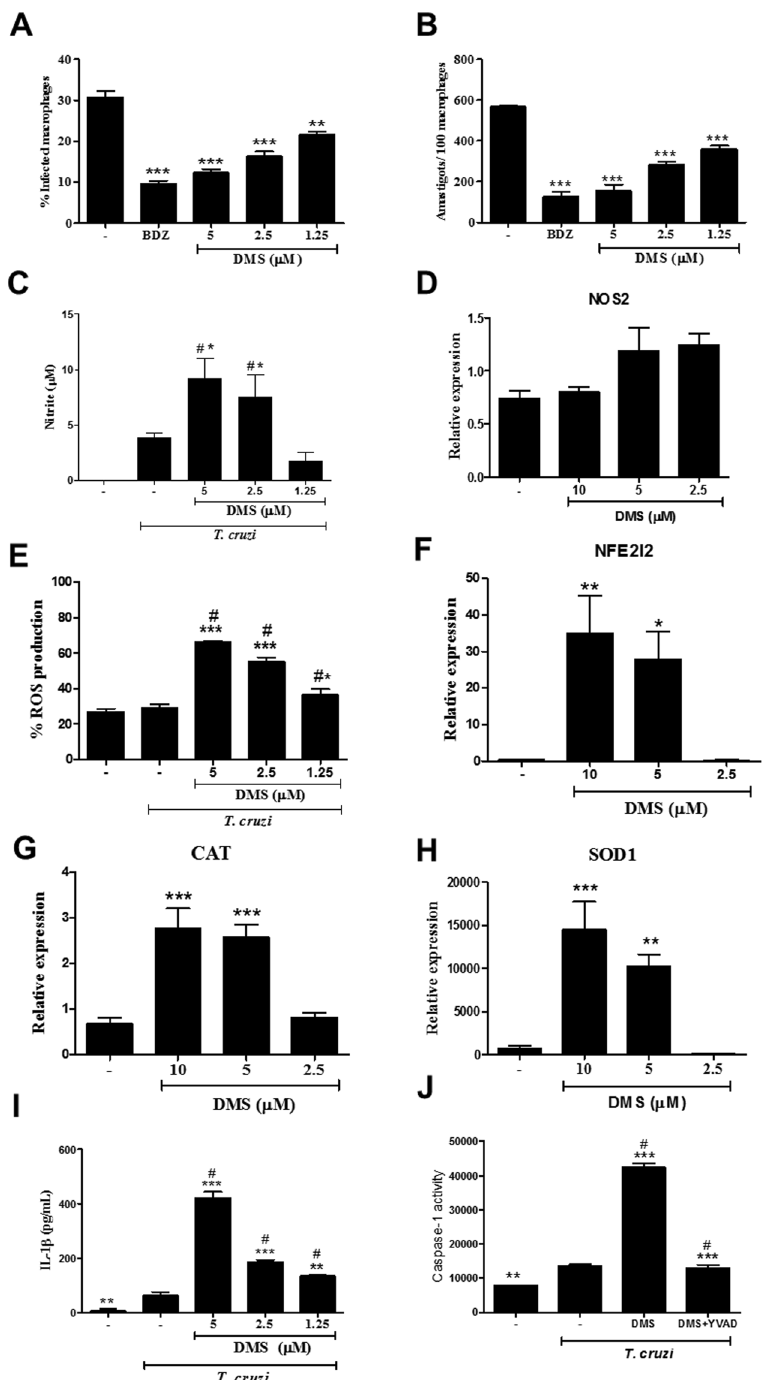
Figure 6. DMS inhibits amastigote proliferation in T. cruzi -infected macrophages, increases NO and ROS and activates caspase 1. The percentage of infected macrophages ( A ) and the relative number of amastigotes per 100 macrophages ( B ) were determined by counting hematoxylin and eosin-stained cultures after 72 hours of treatment. ( C ) Nitric oxide was determined by Griess method after 72 hours of treatment. ( D ) Relative expression of NOS2 gene in infected macrophages treated or not with DMS. ( E ) Reactive oxygen species was quantified by stained with 2 ′ ,7 ′ -dichlorofluorescin diacetate after 30 minutes of treatment. ( F – H ) Relative expression of NFE2I2, CAT and SOD1 genes in infected macrophages treated or not with DMS. ( I ) IL-1 β production quantified by ELISA. ( J ) Caspase-1 activity measured using caspase-Glo 1 inflammasome assay in cultures incubated with complete medium alone, with DMS (5 μ M) or with DMS and YVAD (a caspase-1 inhibitor) in triplicate for 2 h. Values represent means ± SEM of 4 determinations. *** P < 0.001; ** P < 0.01; * P < 0.05 compared to infected and untreated group; # P < 0.05 compared to uninfected and untreated